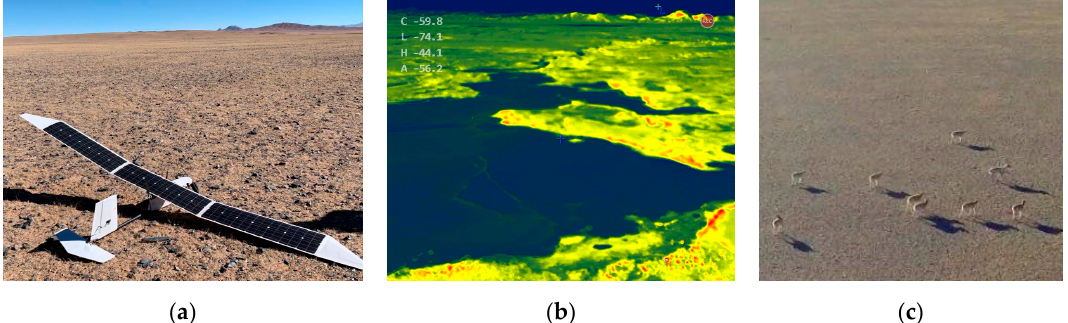
Figure 1 . The solar-powered unmanned aerial vehicle (UAV) used for ecological monitoring and animal protection: ( a ) Mini-Phantom (MP) solar-powered UAV, ( b ) infrared pod for ecological monitoring, ( c ) Tibetan antelopes photographed by optical camera.